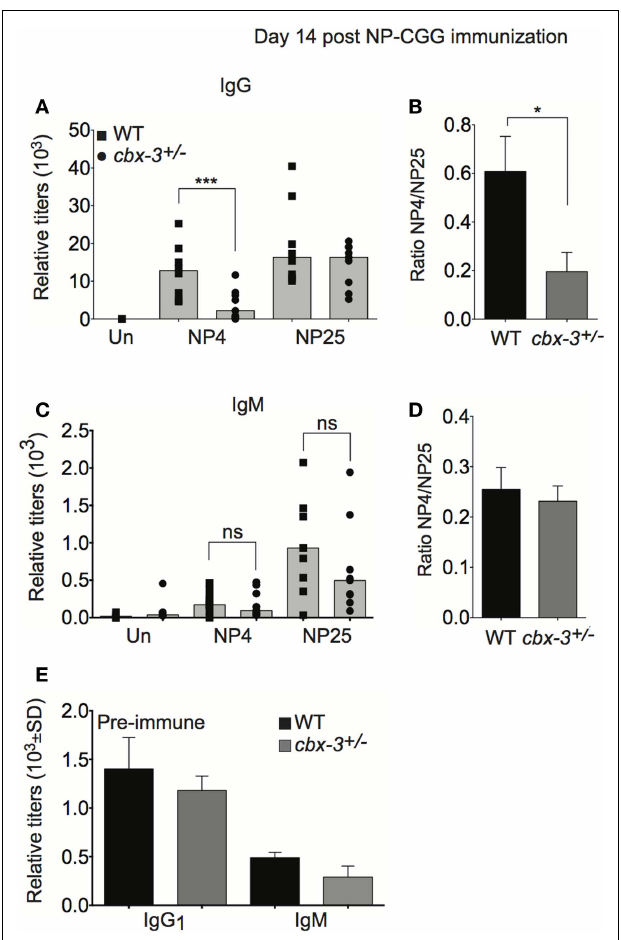
FIGURE 3 | Cbx-3 + / − mice fail to mount the high-affinity NP antibody response . (A) ELISA analysis was carried out to measure high-affinity IgG 1 anti-NP4-BSA and total IgG 1 anti-NP25-BSA antibody activity in sera from mice immunized with NP-CGG in alum. Each symbol represents an individual mouse. Bars represent median. Statistical analysis was performed with GraphPad one-way ANOVA. Day 14, n = 9 for each genotype, *** p = 0.006. (B) High-affinity serum IgG 1 anti-NP Ab activity was determined by calculating the ratio of anti-NP4/NP25, * p = 0.02. (C) Serum IgM anti-NP4 and anti-NP25 antibody activity was analyzed by ELISA to NP-BSA as in (A) . (D) Plot depicts ratio of IgM anti-NP4 over anti-NP25. (E) Total serum IgG 1 and IgM titers of pre-immune sera from (A) were measured by